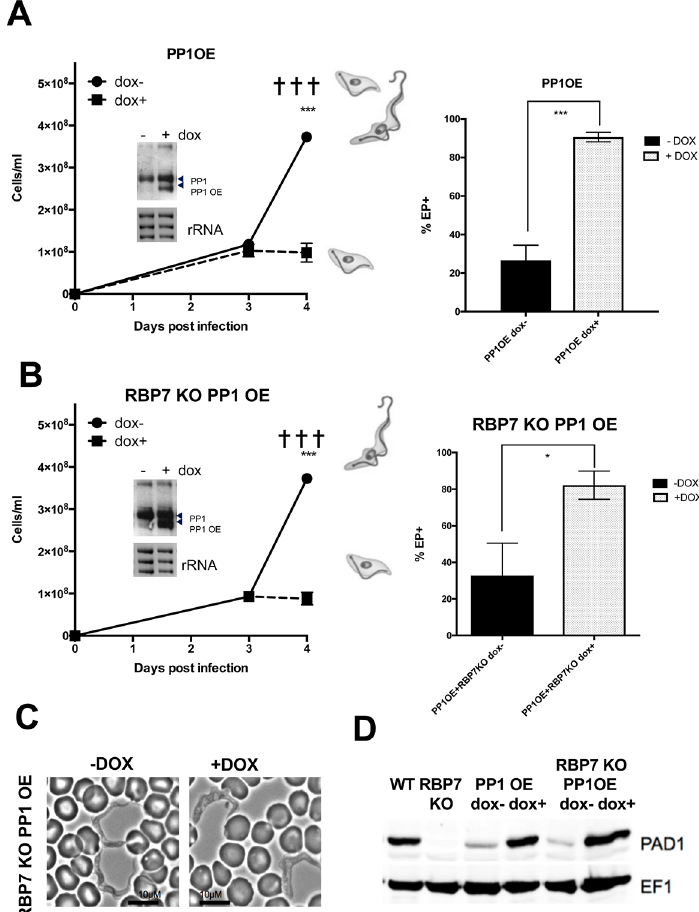
Fig 4. PP1-6 ectopic expression restores stumpy formation in RBP7 null mutants. A. Inducible ectopic expression of PP1-6 in T . brucei EATRO 1125 AnTat1.1 90:13 parental cells ( ■ , +dox; ● , -dox) ( (cid:3)(cid:3)(cid:3) p < 0.0005). The dominant morphology of the cells on day 4 is shown schematically, which was stumpy in the induced samples and a mixture of slender, intermediate and stumpy in the uninduced samples. The inset northern blot shows PP1 transcript levels in the induced and uninduced cells; rRNA is the loading control. The right panel shows the expression of EP procyclin 4 hours after parasites were harvested on day 4 of infection and incubated in 6mM cis aconitate ( (cid:3)(cid:3)(cid:3) p < 0.0005). Infection terminated on humane grounds, ✝ . B. Inducible ectopic expression of PP1-6 in T . brucei EATRO 1125 AnTat1.1 90:13 RBP7AB null mutants ( ■ , +dox; ● , -dox); ( (cid:3)(cid:3) p < 0.005). The dominant morphology of the cells on day 4 is shown schematically. The inset northern blot shows PP1 transcript levels in the induced and uninduced cells; rRNA is the loading control. The right panel shows the expression of EP procyclin 4 hours after parasites were harvested on day 4 of infection and incubated in 6mM cis aconitate ( (cid:3) p < 0.05). C. Morphology of RBP7AB null mutants induced (+dox) or not (-dox) to express PP1-6 (RBP7 KO PP1 OE). Bar = 10μm. D. Western blot of PAD1 expression in parental parasites (WT), RBP7AB null mutant (RBP7 KO) cells, or in parental cells (‘PP1 OE’) or in the null mutant (RBP7KO PP1 OE) induced (+dox) or not (-dox) to ectopically express PP1-6. The RBP7AB null mutant expresses PAD1 upon PP1-6 ectopic expression. EF1alpha provides a loading